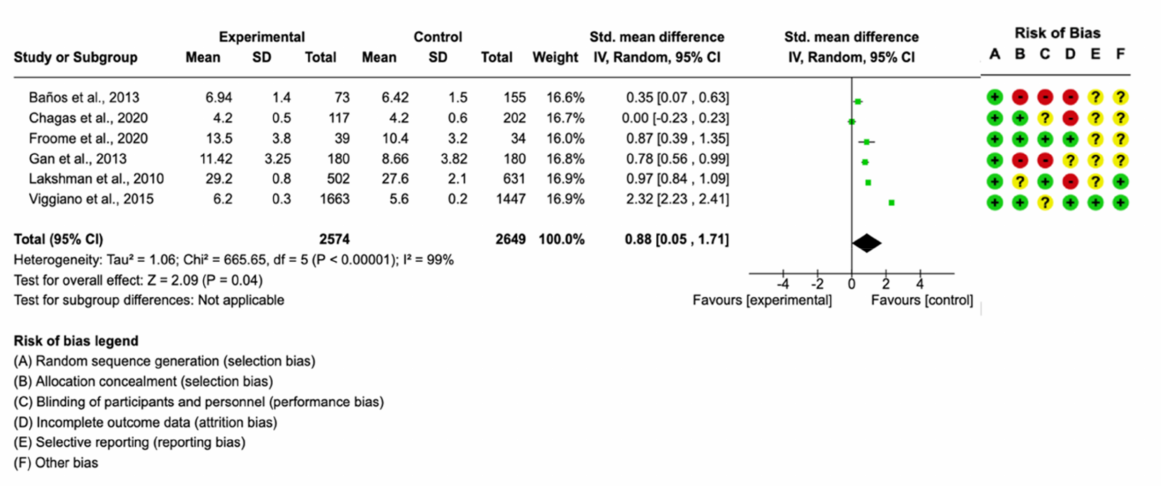
Figure 2. Forest plot for nutritional